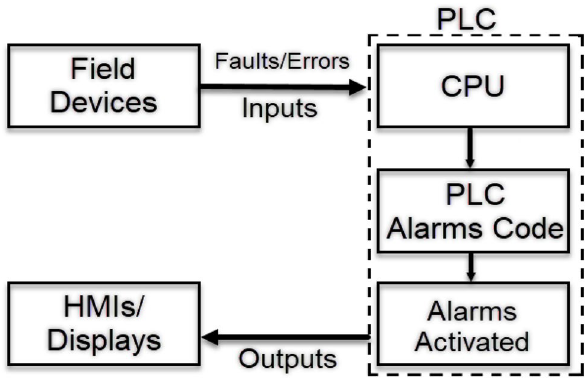
Fig. 1 PLC flow in capturing and triggering